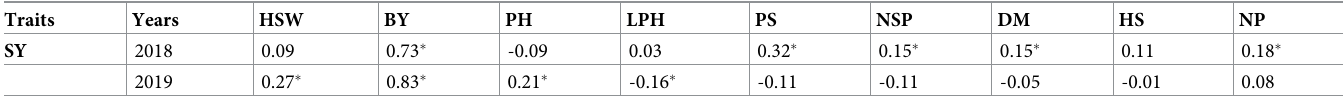
Table 4. Pearson Correlation matrix for SY with other quantitative traits of lentil grown in 2017–18 and 2018–19. Traits